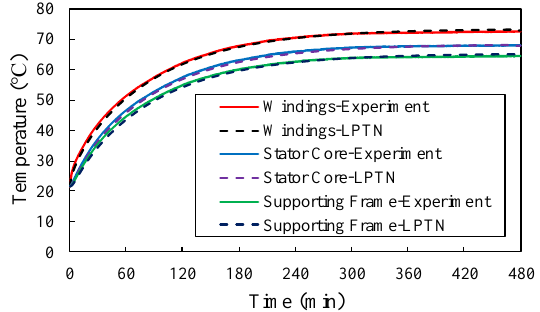
Figure 19. Instantaneous temperature-rise test of the prototype under 11 A DC.